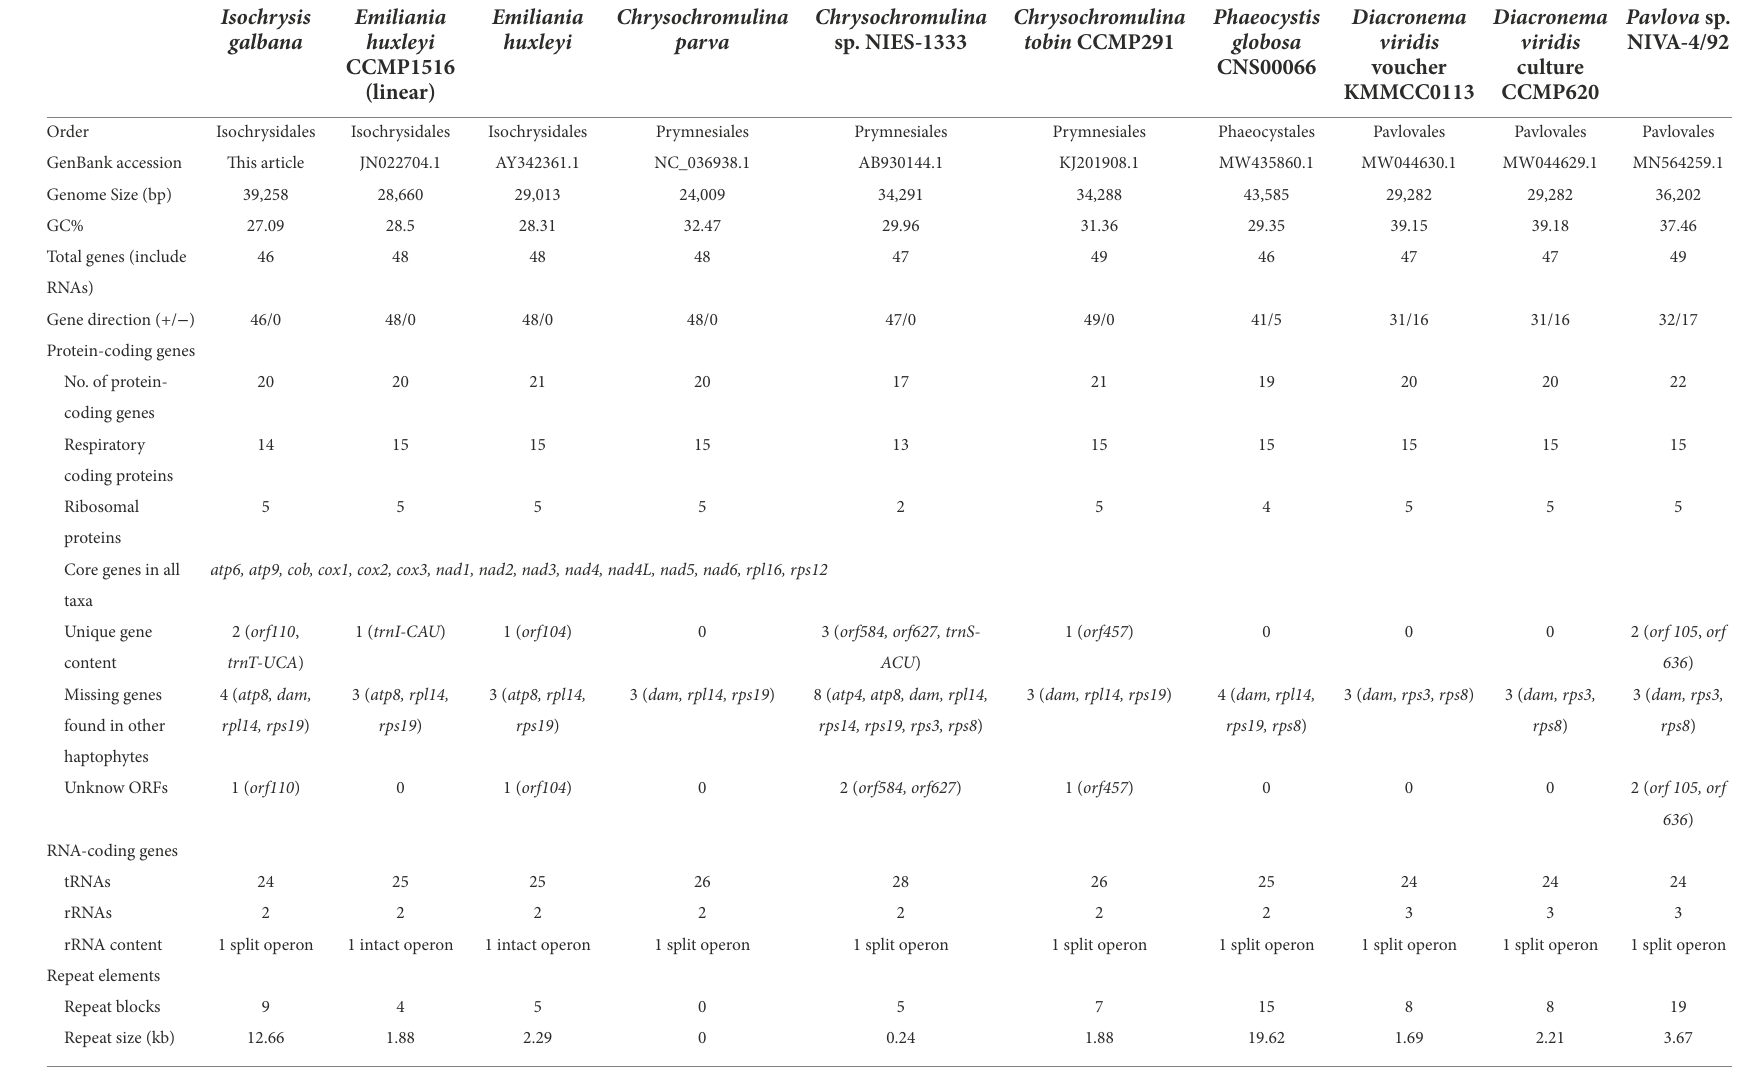
TABLE 1 Comparison and characteristics of haptophyte mitochondrial